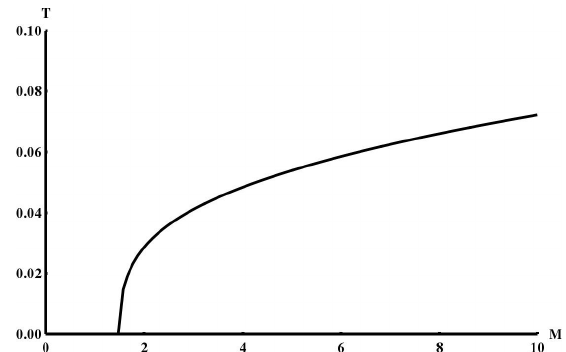
Figure 6. Temperature–mass dependence for Dadhich–Molina black holes in the q = 0 case. Reproduced from